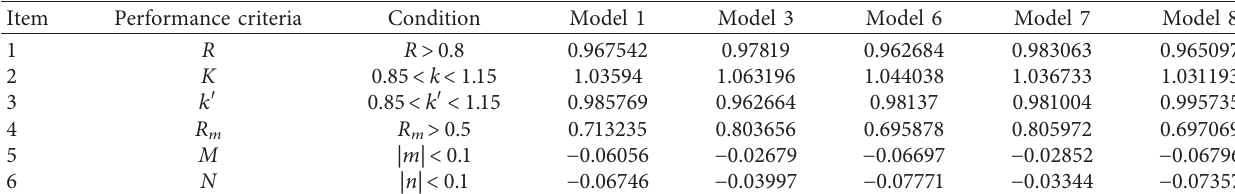
Table 4: External validation statistical measures for different